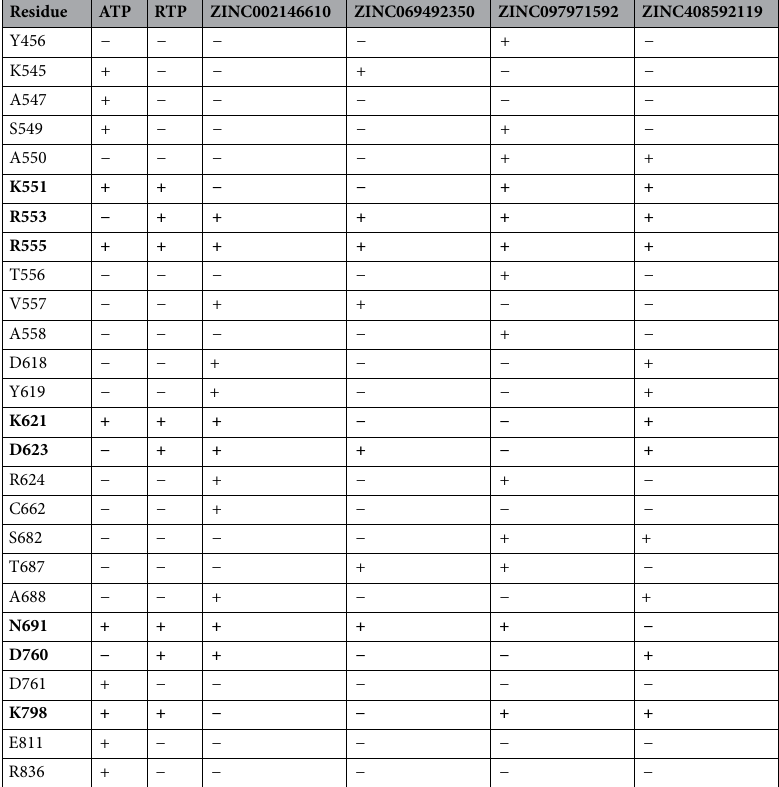
Table 4. Ligand–protein contacts during simulation from ATP, RTP and the four ZINC compound systems. Ligand–protein contacts may consist of hydrogen bonding, lipophilic, hydrophobic and electrostatic interactions. Contacts shown are present in at least 30% of trajectory time. Bold are residues that interacted with at least 3 of the six tested